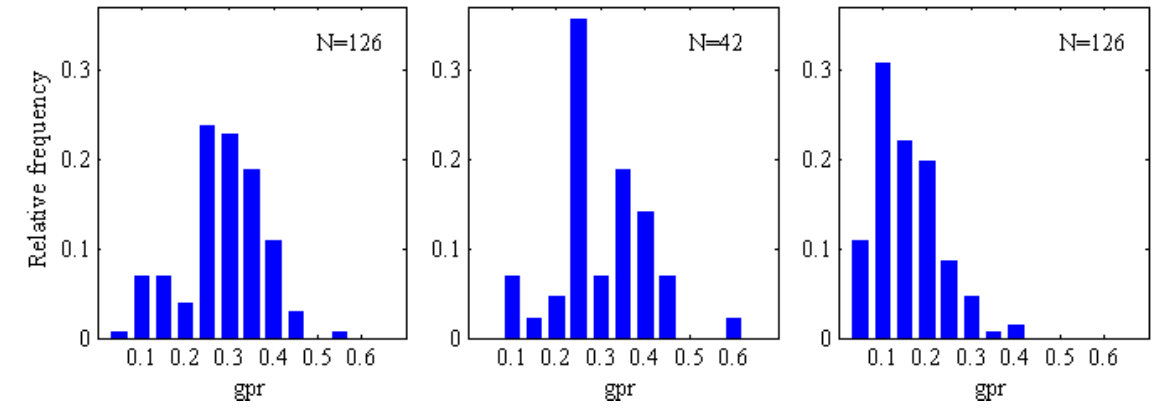
Figure 4. Histograms of ghost points ratio ( gpr ) values over the total number of measurements (N). ( a ) The leaves setup ( N = 126); ( b ) the layers setup ( N = 42) and ( c ) the branches setup ( N =